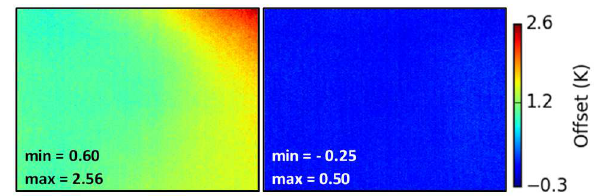
Figure 9. Image offsets from true temperature of a blackbody at minute 40, prior to (left) and after (right) applying corrections.